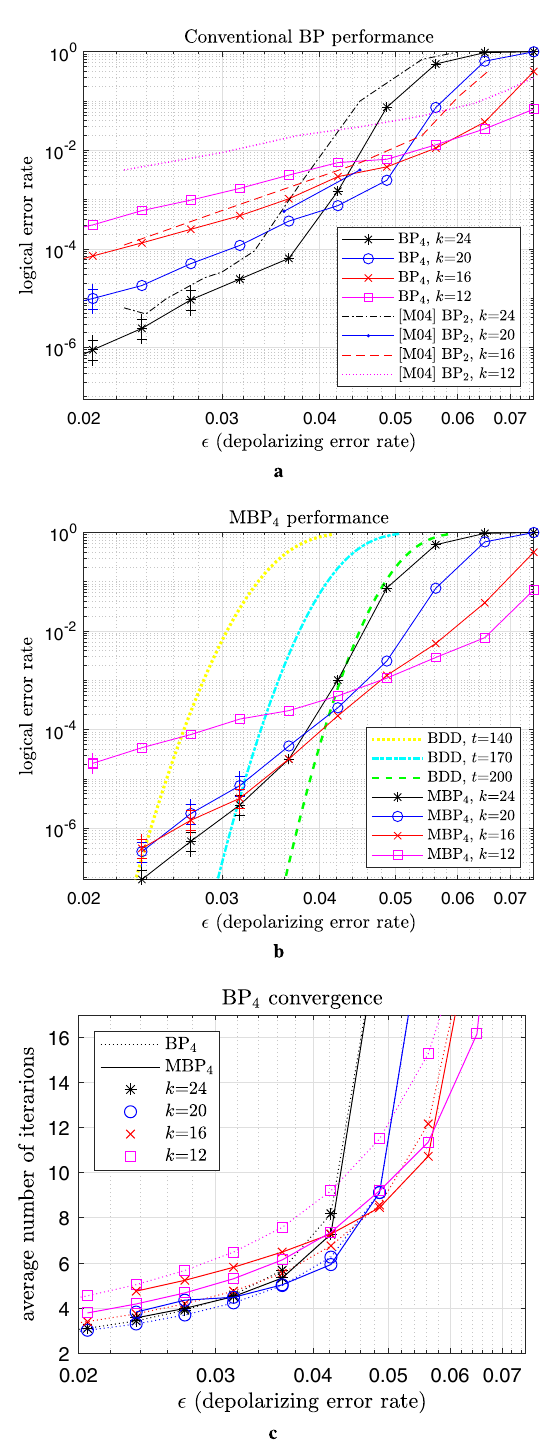
Fig. 1 Performance of parallel BP 4 and MBP 4 on the [[3786, 946]] bicycle codes of different row-weights ( k ), based on T max ¼ 90. a MBP 4 with α = 1 (conventional BP 4 ). b MBP 4 with appropriate α > 1 chosen for each ϵ . c Average numbers of iterations in a (dotted lines) and b (solid lines). The [M04] curves in a are obtained using a conversion from bit- fl ip error rate to depolariz- ing error rate, based on Fig. 6 and Eq. (40) in ref. 10 . In a and b , 100 logical error events are collected for each data point; or otherwise, an error bar between two crosses indicates the 95% con fi dence